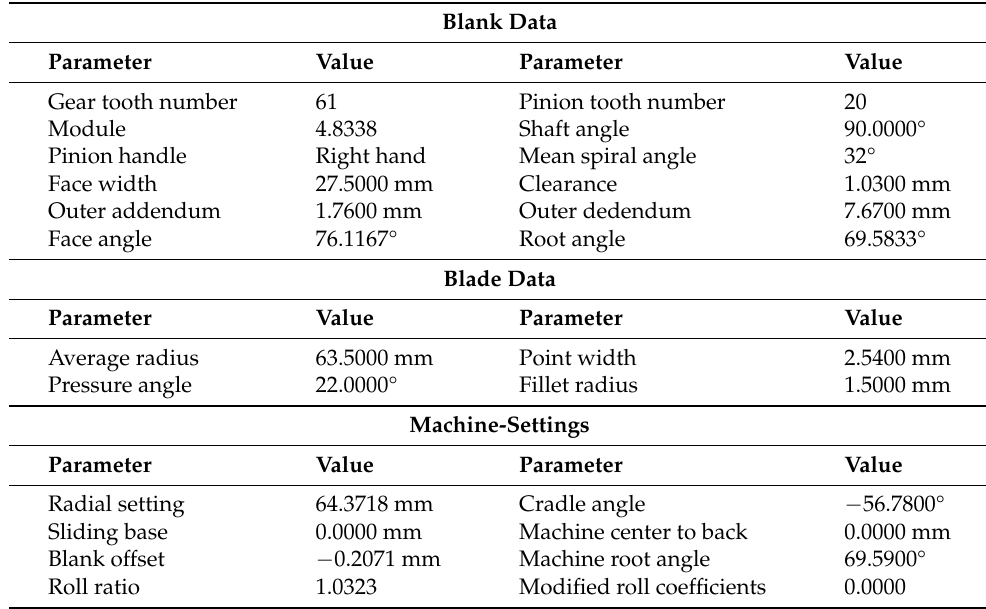
Table 1. Main data of a face-milled generated